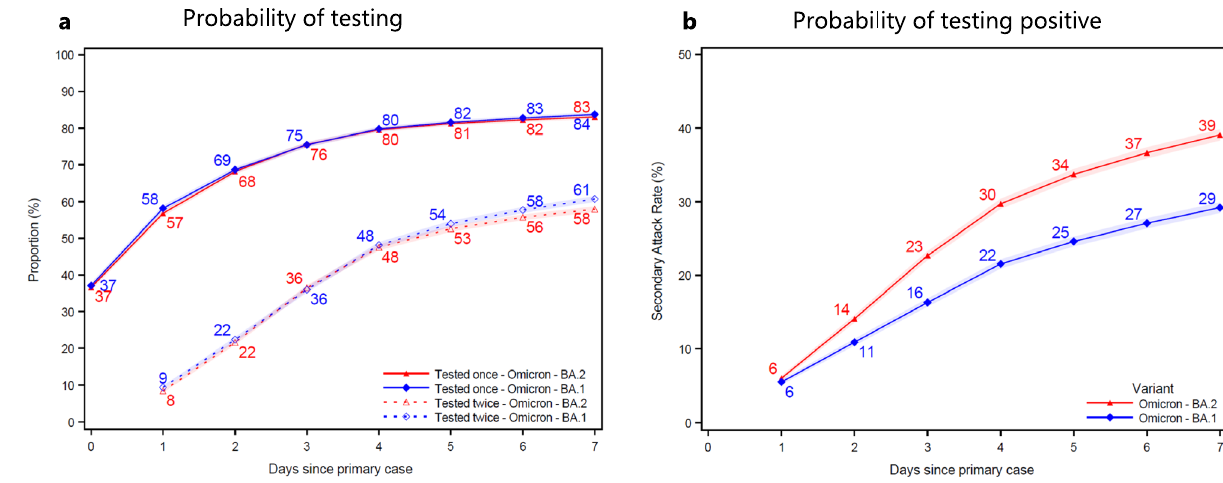
Fig. 1 | Probability of being tested and testing positive. Panel a shows the probability of household contacts being tested after a primary case has been identi fi ed within the household. Panel b shows the probability of household con- tacts that test positive subsequently to a primary case being identi fi ed within the household. Note that the latter is not conditional on being tested, i.e., the denominator contains test-negative individuals and untested individuals. The